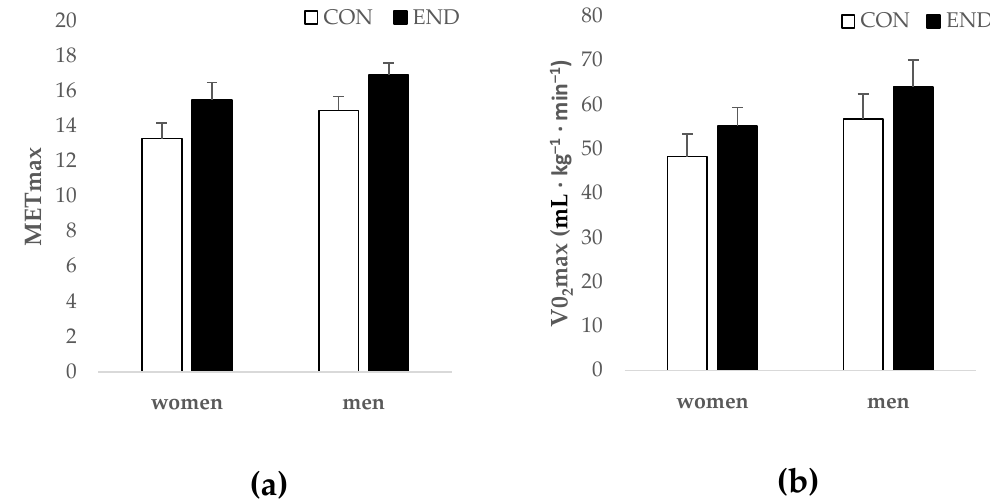
Figure 2. ( a ) Maximum metabolic equivalent of task (METmax) and ( b ) maximum oxygen consumption (VO 2 max) in women and men who were endurance trained subjects (END) and healthy controls (CON).